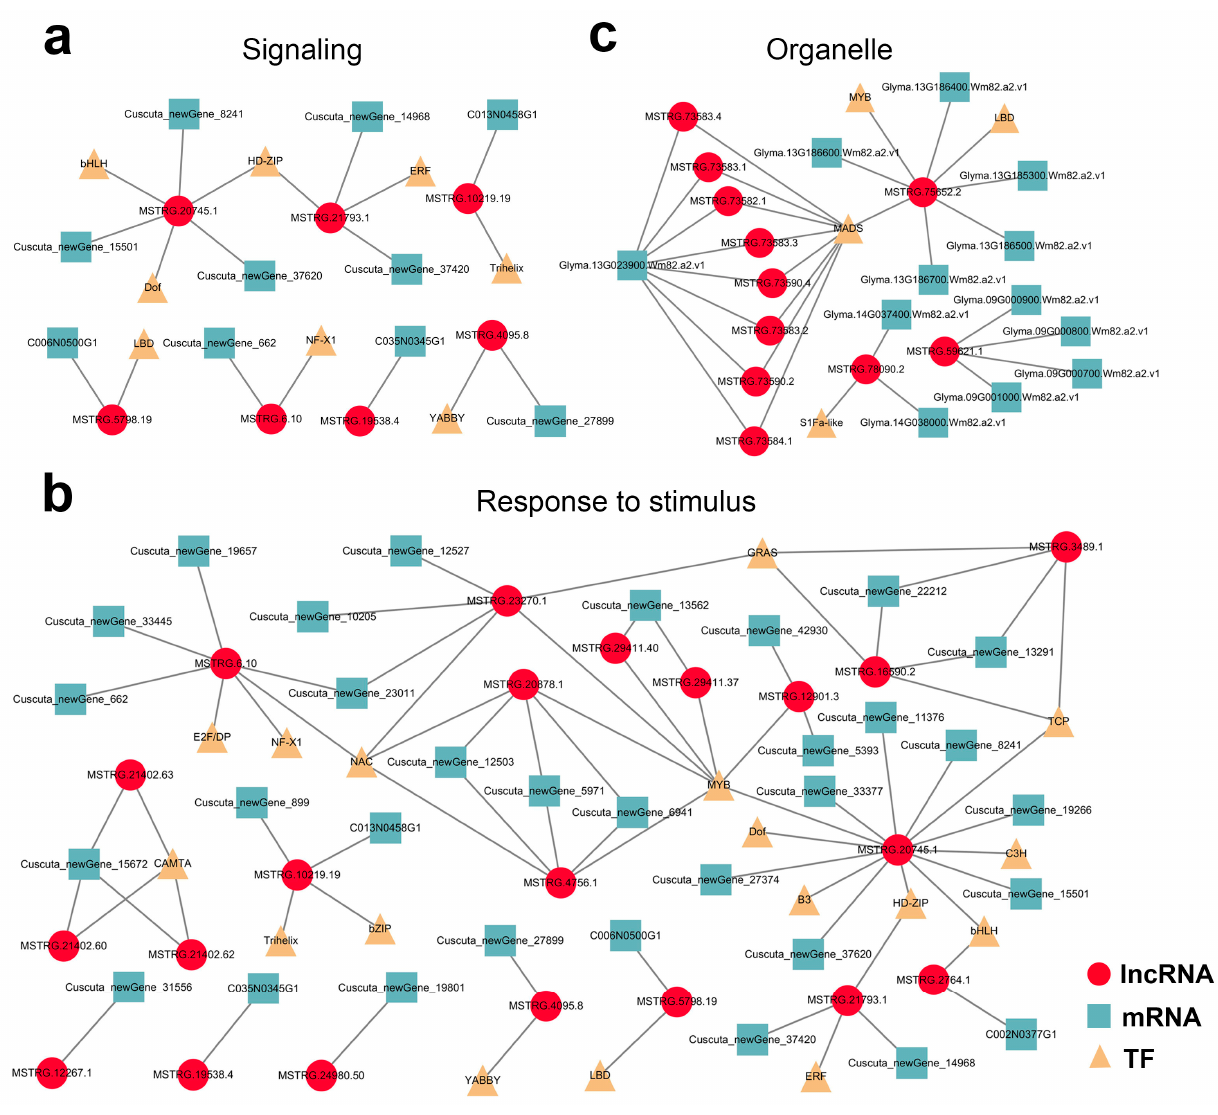
Figure 8. Potential lncRNA–mRNA/TF network in parasitic system visualized using Cytoscape 3.7.2: ( a , b ) Predicted network of mobile dodder lncRNAs and their targeted mRNAs/TFs enriched in “signaling” term ( a ) or “respond to stimulus” term ( b ); ( c ) Predicted network of mobile soybean lncRNAs and their targeted mRNAs/TFs enriched in “organelle part” term. Red circles represent lncRNAs, blue squares represent mRNAs, and yellow triangles represent TFs.